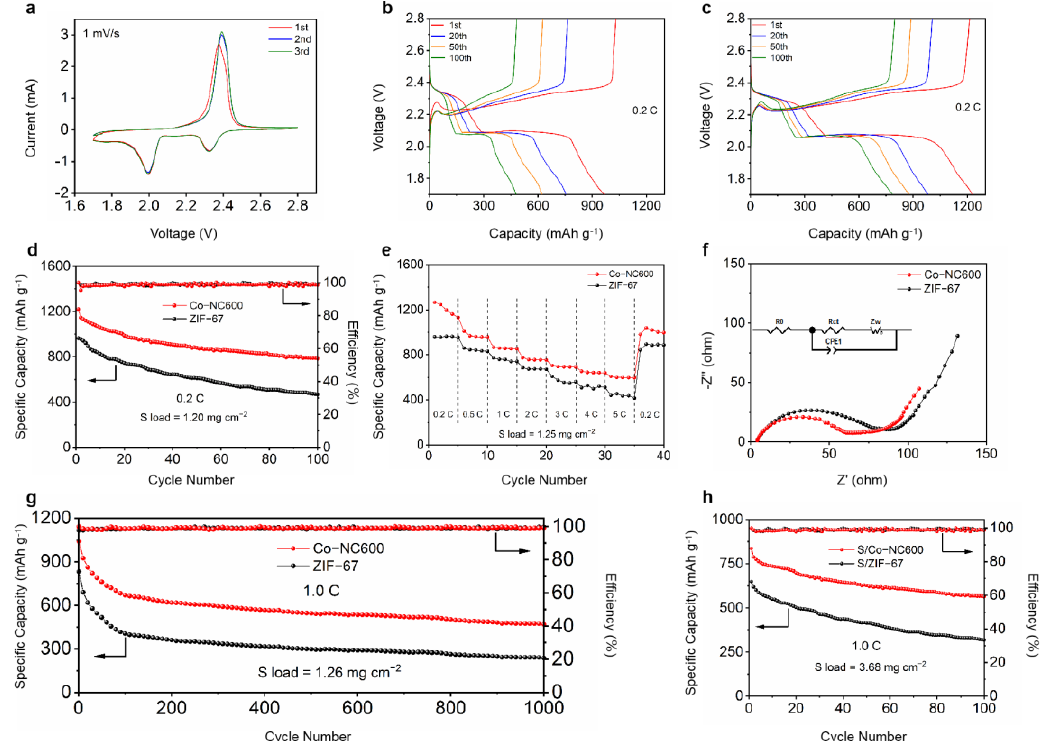
Figure 4. ( a ) CV curves of the cells with the S/Co-NC600 electrode; charge/discharge profiles of ( b ) S/ZIF-67 and ( c ) Co- NC600 electrodes; ( d ) cycling performances of S/ZIF-67 and S/Co-NC600 electrodes; ( e ) rate performances of S/ZIF-67 and S/Co-NC600 electrodes; ( f ) EIS spectra of cells with the cathodes of S/ZIF-67 and S/Co-NC600, where the inset is the equivalent circuit used to fit the impedance spectrum; ( g ) long-term cycling performances of S/ZIF-67 and S/Co-NC600; and ( h ) cycling performances of high-sulfur loading electrodes. The meaning of arrow in d, g and h is to show what the ordinate of the corresponding curve means. The left arrow represents the specific capacity and the right arrow represent efficiency of the curves.